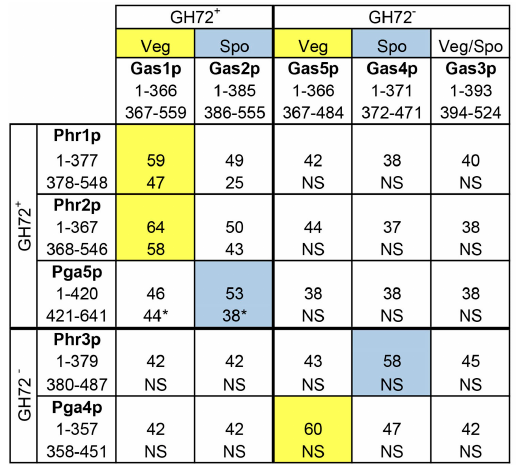
Figure 4. Comparison of amino acid sequences of PHR and GAS families. Colored blocks indicate C. albicans proteins most closely related to functionally defined S. cerevisiae proteins. Yellow: proteins active in cell wall assembly during vegetative growth of S. cerevisiae. Light blue: proteins active in spore wall assembly in S. cerevisiae . * indicates the presence of a Poly(Glu) tract in the Pga5p C-terminal region.